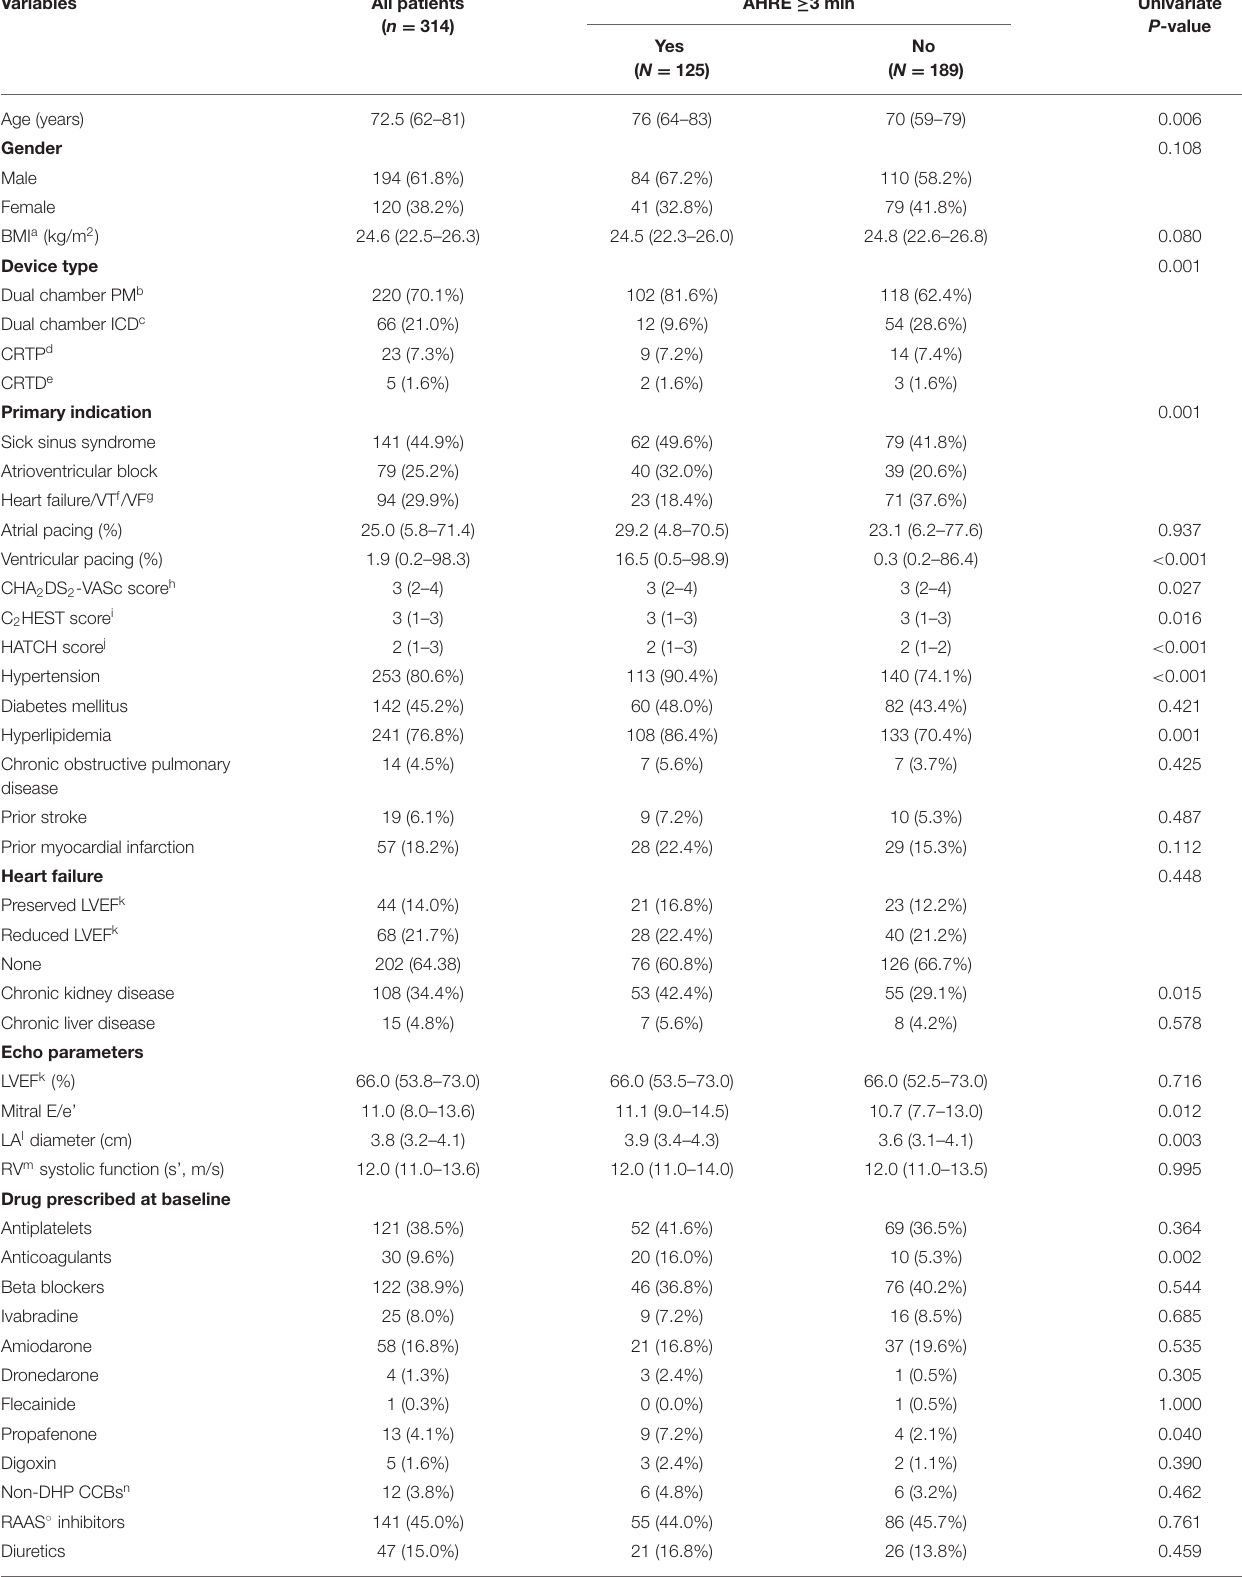
TABLE 4 | Baseline characteristics of the overall study group and with/without AHRE ≥ 3min.